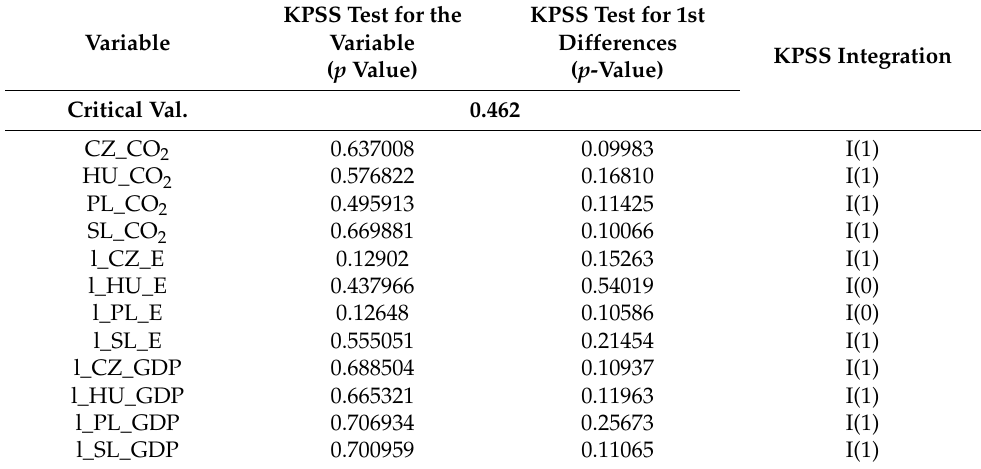
Table 4. Unit Root Test—KPSS Test Results.